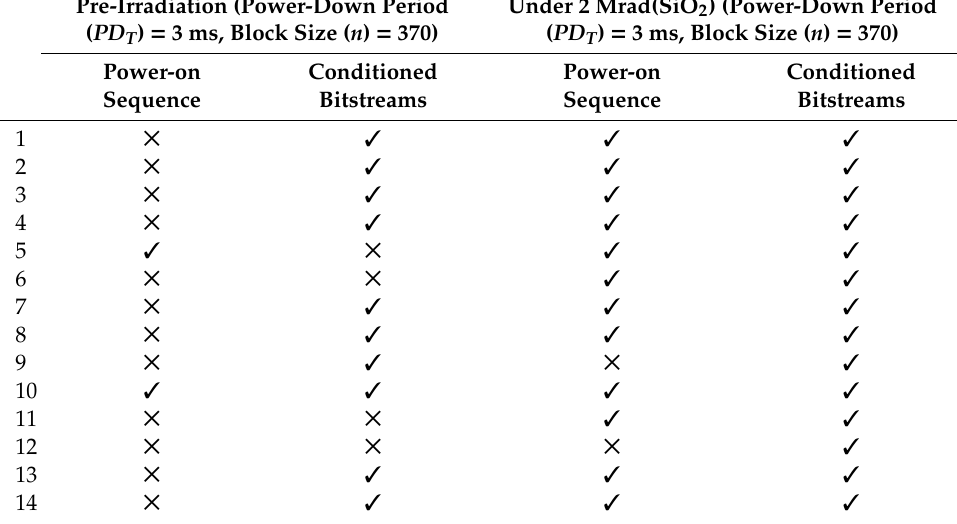
Table 1. National Institute of Standards and Technology (NIST) test results for di ff erent bitstreams. The list of applied tests is as follows: (1) monobit frequency test, (2) block frequency test, (3) run test, (4) longest run, (5) binary matrix rank, (6) spectral test, (7) non-overlapping template